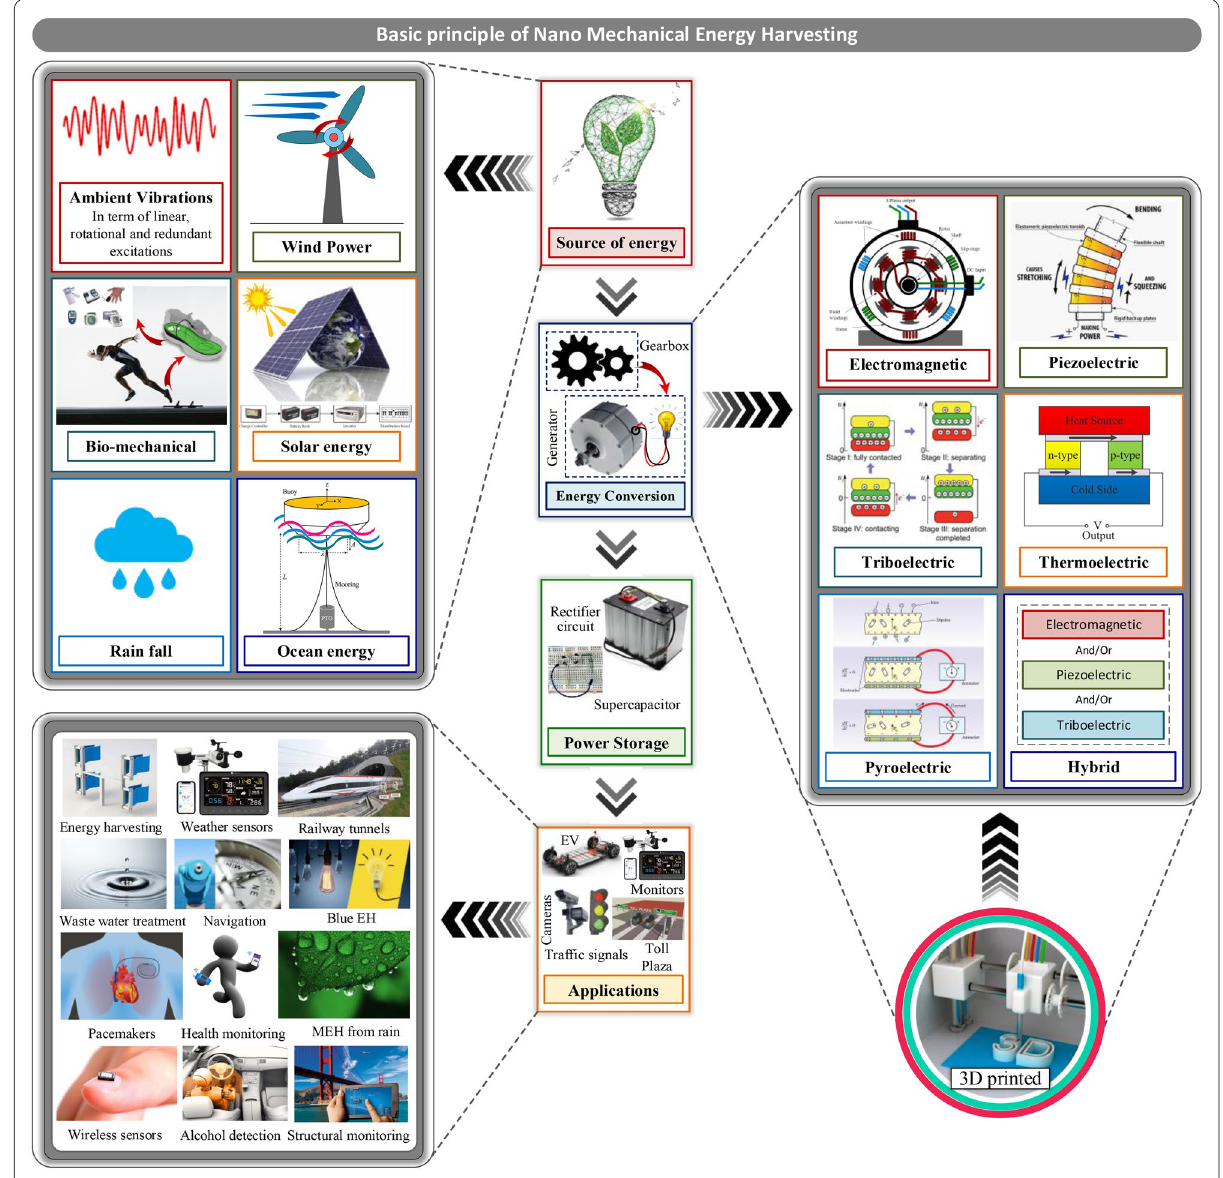
Fig. 2 Schematic of nanomechanical energy harvesting along with various energy sources, energy conversion methods and potential